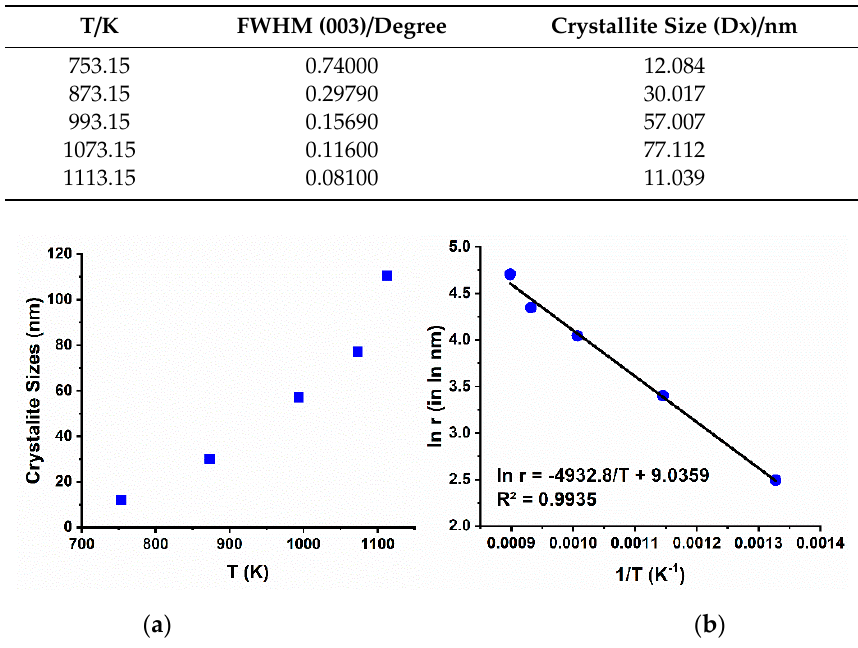
Figure 9. ( a ) Crystalite size plot toward sintering temperature and ( b ) Arrhenius plot for activation energy determination during crystal formation.